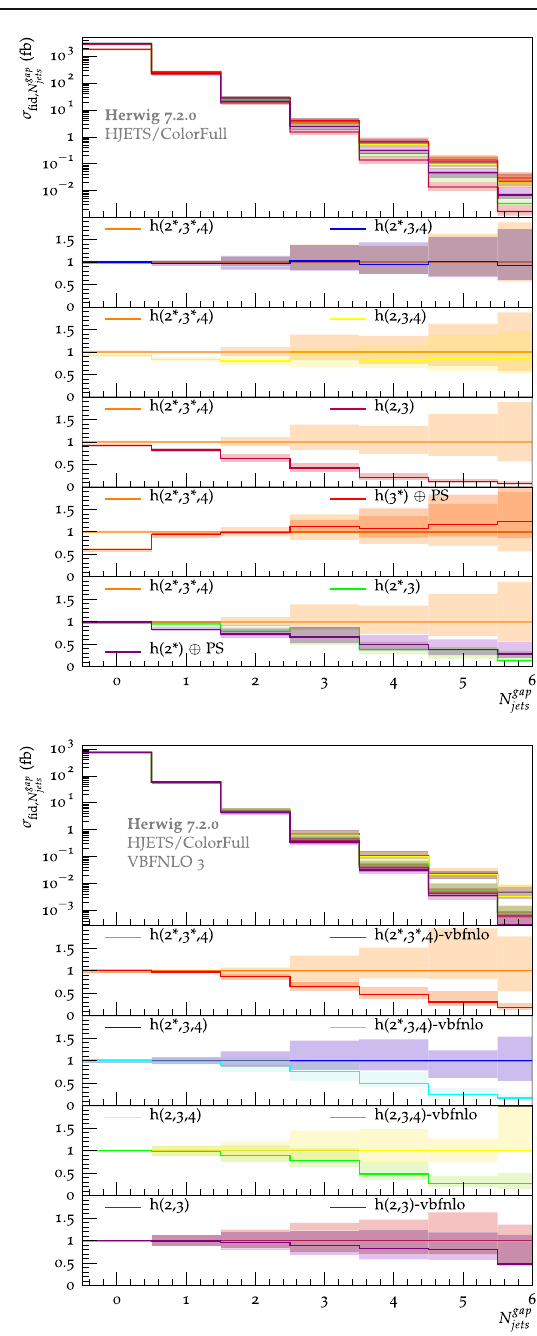
Fig. 5 Exclusive number of jets (left column) and the exclusive num- being the reference in the ratio plots for top row. In the bottom row ber of gap jets (right column) with INCL (top row) and TIGHT (bot- setups using VBFNLO MEs are compared against setups using HJets tom row) selection cuts for the predictions of h ( 2 (cid:3) , 3 (cid:3) , 4 ) , h ( 2 (cid:3) , 3 , 4 ) , MEs. Shown in the figures are theory error bands due to the variation (cid:2) (cid:2) h ( 2 , 3 , 4 ) , h ( 2 (cid:3) , 3 ) , h ( 2 , 3 ) , h ( 3 (cid:3) ) PS, and h ( 2 (cid:3) ) PS. h ( 2 (cid:3) , 3 (cid:3) , 4 ) of the factorization and renormalization scales the matching by merging setups h ( 2 (cid:3) , 3 ) . It is quite obvi- MEs up to 50% in the tail of the distribution for the transverse ous that relying on the parton shower alone without includ- momentum of the third jet for merged setup h ( 2 (cid:3) , 3 (cid:3) , 4 ) . For the centrality of the third jet, we see the largest deviations ing the h + 4 parton hard scattering matrix elements fails to when using NLO MEs. All predictions deviate at the level describe the higher jet multiplicities beyond 2. In the bottom = 0. This is the result of the missing s - 40% around z ∗ row of Fig. 7 using LOOSE selection cuts we see deviations j 3 channel contributions in the VBFNLO between predictions based on VBFNLO MEs and the HJets